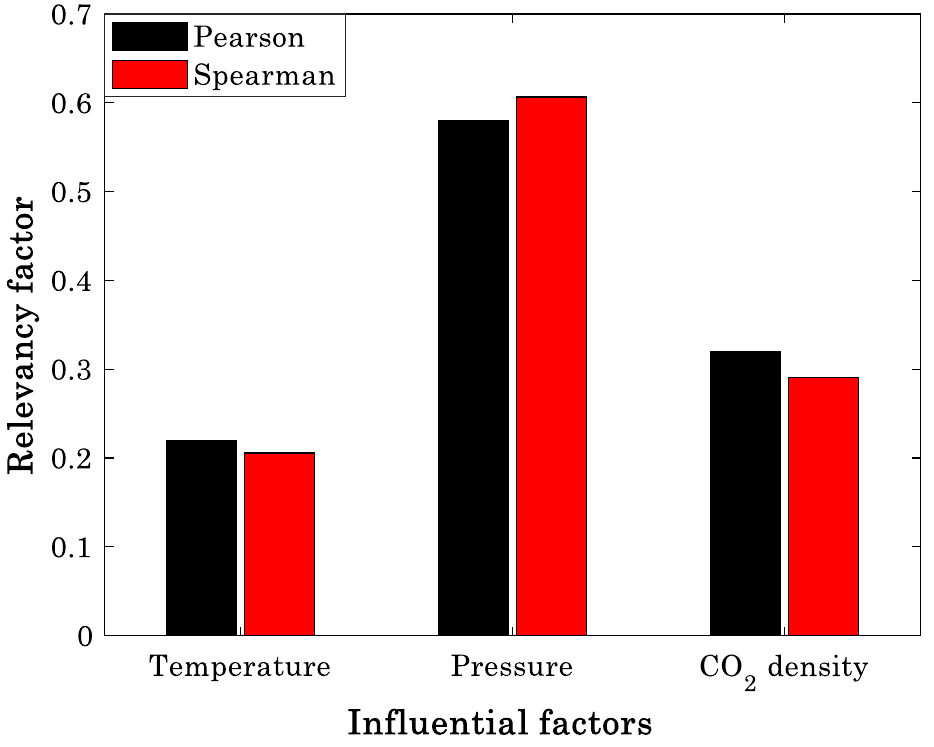
Figure 1. Relevancy between the solubility of anti-cancer drugs in supercritical CO 2 and temperature, pressure, and carbon dioxide